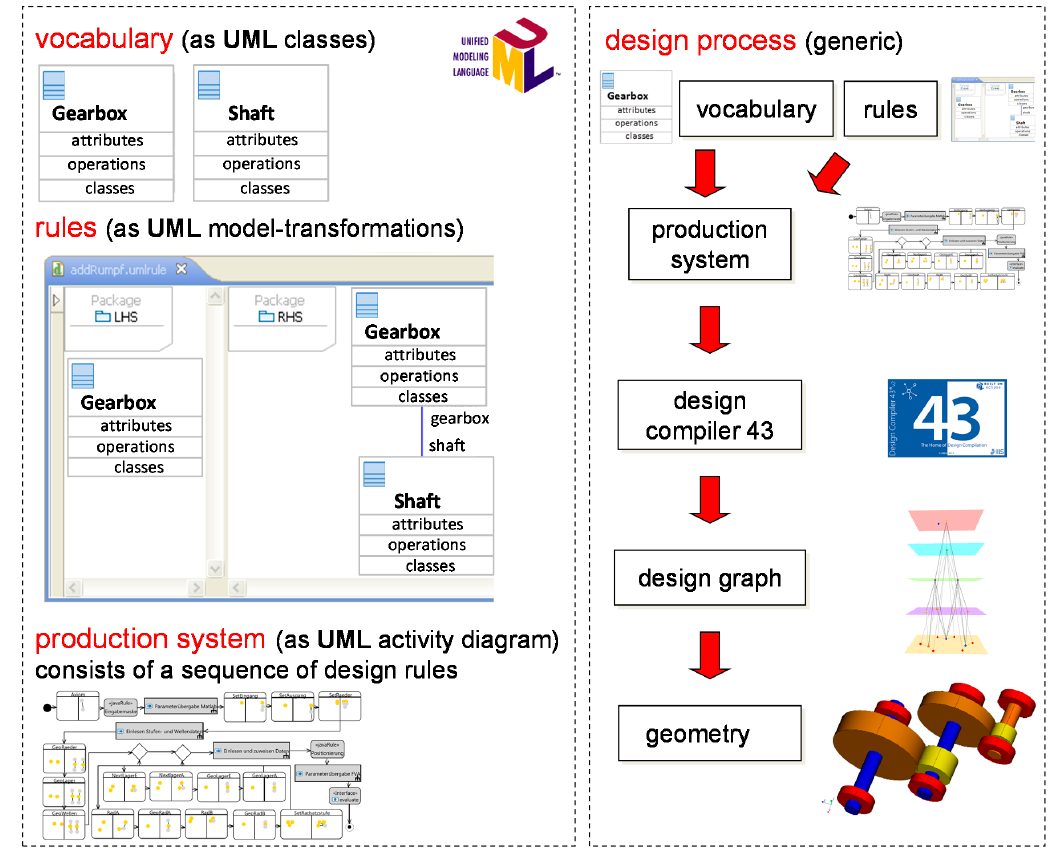
Figure 8. Application of a graph-based design language and usage of Unified Modelling Language (UML) diagrams.